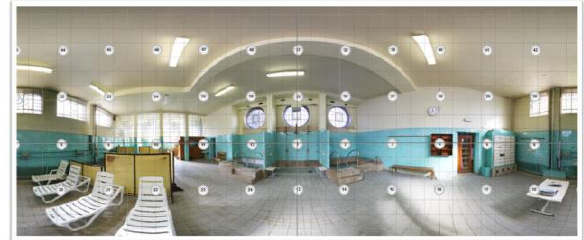
Figure 5: Panoramic composition in spherical projection calculated with Autopano Giga tool (Kolor).